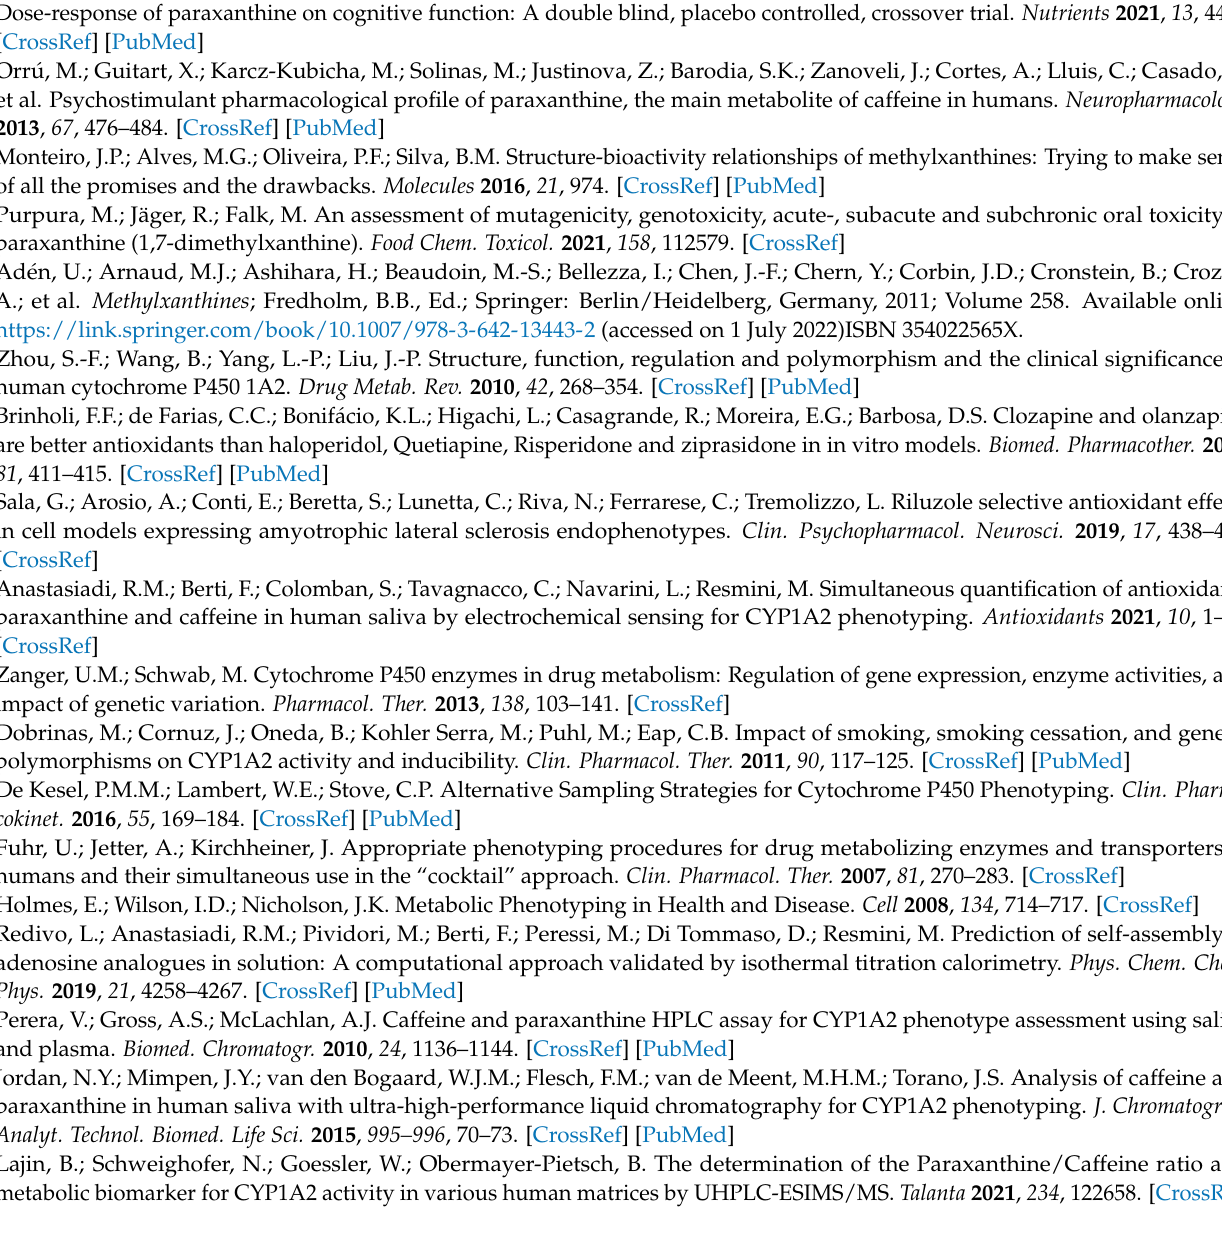
0.5 mg/mL in D 2 O. Figure S18: 1H-NMR interaction study between PX (0.5 mg/mL, 2.78 mM) and AM (1-5 equivalents), Figure S19: 1H-NMR interaction study between PX (0.5 mg/mL, 2.78 mM)